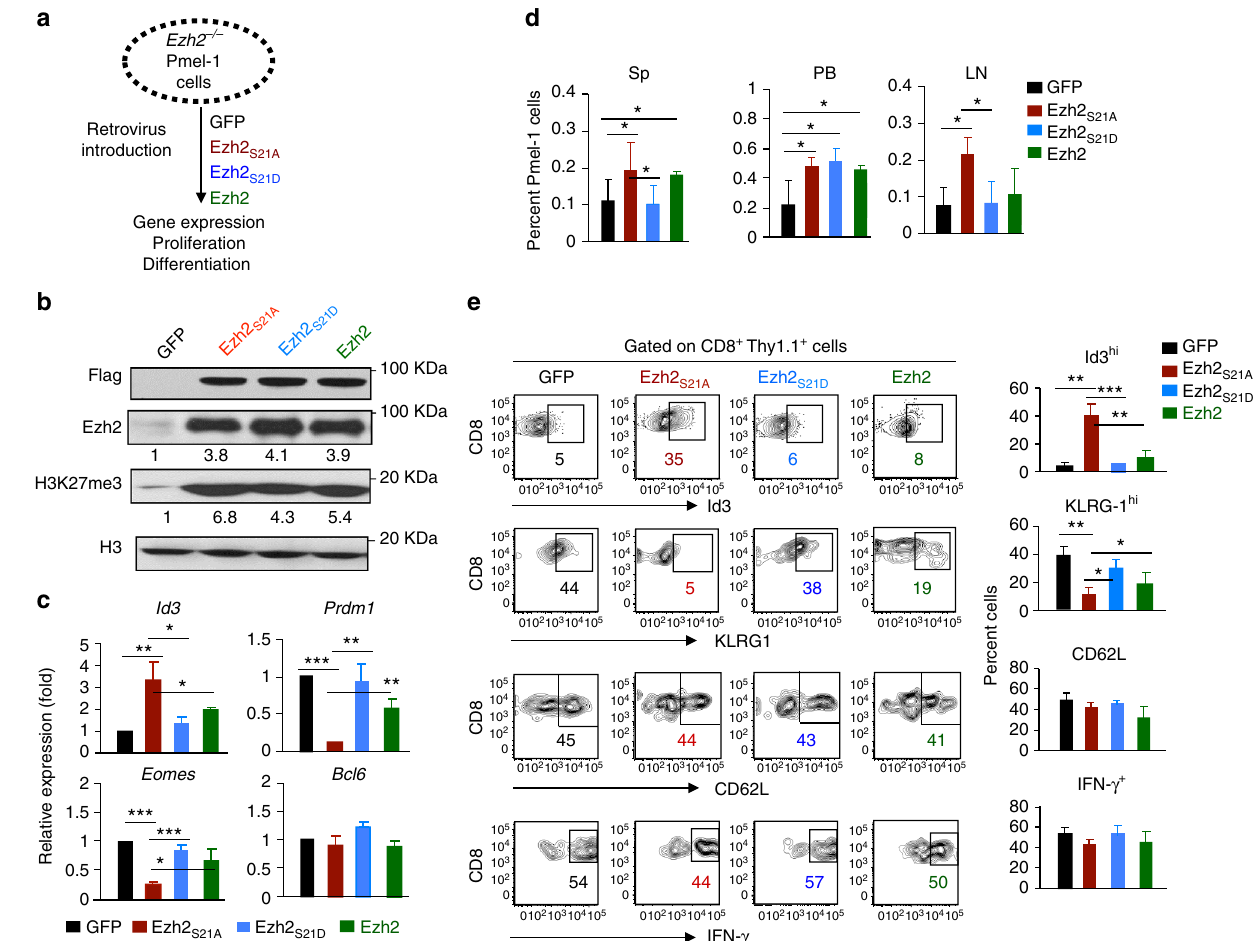
Fig. 6 Inhibiting Akt-mediated phosphorylation of Ezh2 enhances the generation of T CMP . Ezh2 − / − Pmel-1 cells (Thy1.1 + ) were stimulated with anti-CD3/ CD28 Ab + IL-2 for 36 h, followed by infection with MigR1 retrovirus encoding GFP, Ezh2, Ezh2 S21D and Ezh2 S21A , respectively. At 7 days, after stimulation, these infected T cells were collected. a Experiment scheme. b Immunoblot analysis of Pmel-1 cells transduced with GFP, Ezh2, Ezh2 S21D and Ezh2 S21A , probed with Flag, H3K27me3 and H3. c RT-PCR analysis of gene expression in Pmel-1 cells transduced by indicated genes. d , e These 7 day-Pmel-1 cells (Thy1.1 + ) were transferred into sublethally irradiated B6 mice (Thy1.2 + ), followed by treatment with IL-2 and gp100-DCs for 3d after transfer. d Donor T cells were collected from the spleen, PB and LN at 6d after adoptive transfer, and measured by fl ow cytometric analysis. e Plots and graphs show the percentage of of Id3 hi , KLRG1 hi , CD62L + and IFN- γ + within donor T cells from the spleen. * p < 0.05, ** p < 0.01, and *** p < 0.001 (two-tailed unpaired t test). The data are representatives of three experiments ( b , c ; mean ± SD) or two experiments with n = 4 mice per group in each ( d , e ; mean ±